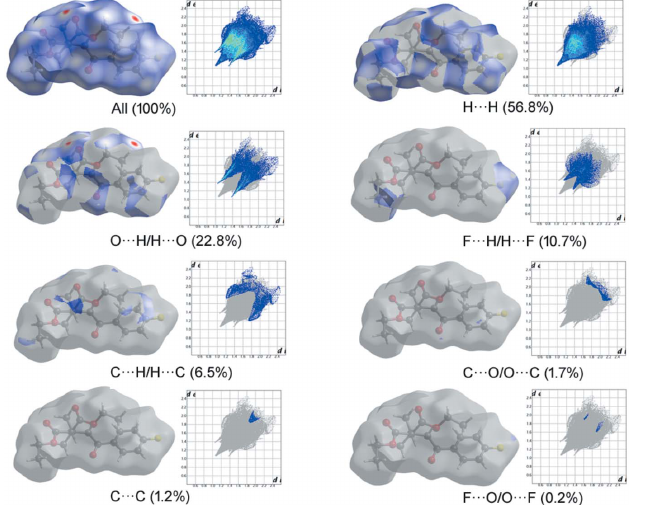
Figure 4 Two-dimensional fingerprint plots and relative contributions of various interactions to the Hirshfeld surface of the title